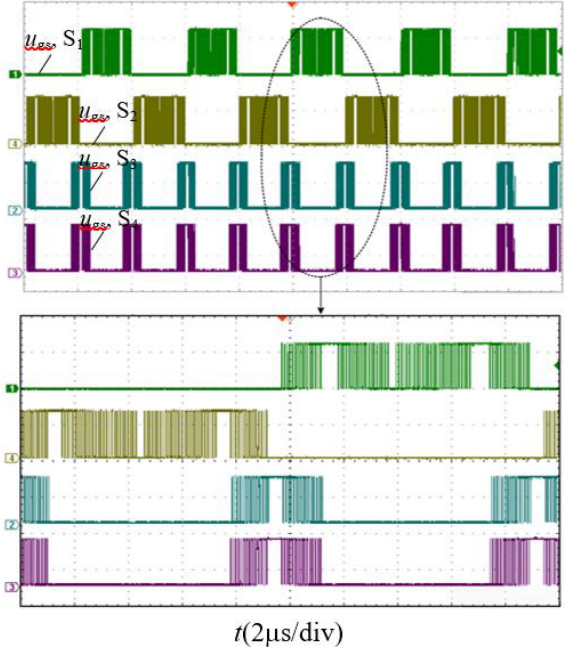
Figure 10. The pulse distribution waveforms of four switches in the STL-PFC.